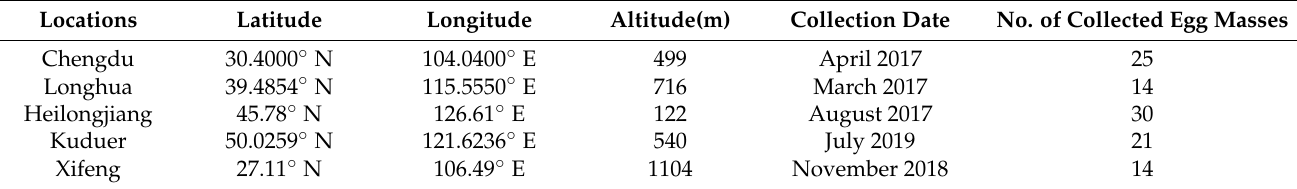
Table 1. Estimated locations (latitude, longitude and altitude) of five sampling areas of Asian spongy moths ( L. dispar asiatica) in China.